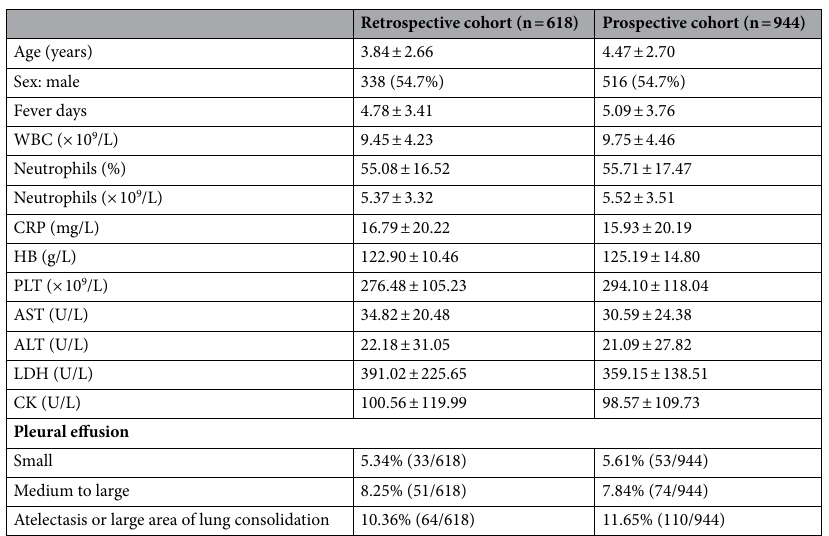
Table 1. Admission characteristics of the children in the retrospective and prospective cohorts. Values are presented as mean ± SD. ALT alanine aminotransferase, AST aspartate aminotransferase, CK creatine kinase, CRP C-reactive protein, HB hemoglobin, LDH lactate dehydrogenase, PLT platelets, WBC white blood cells.